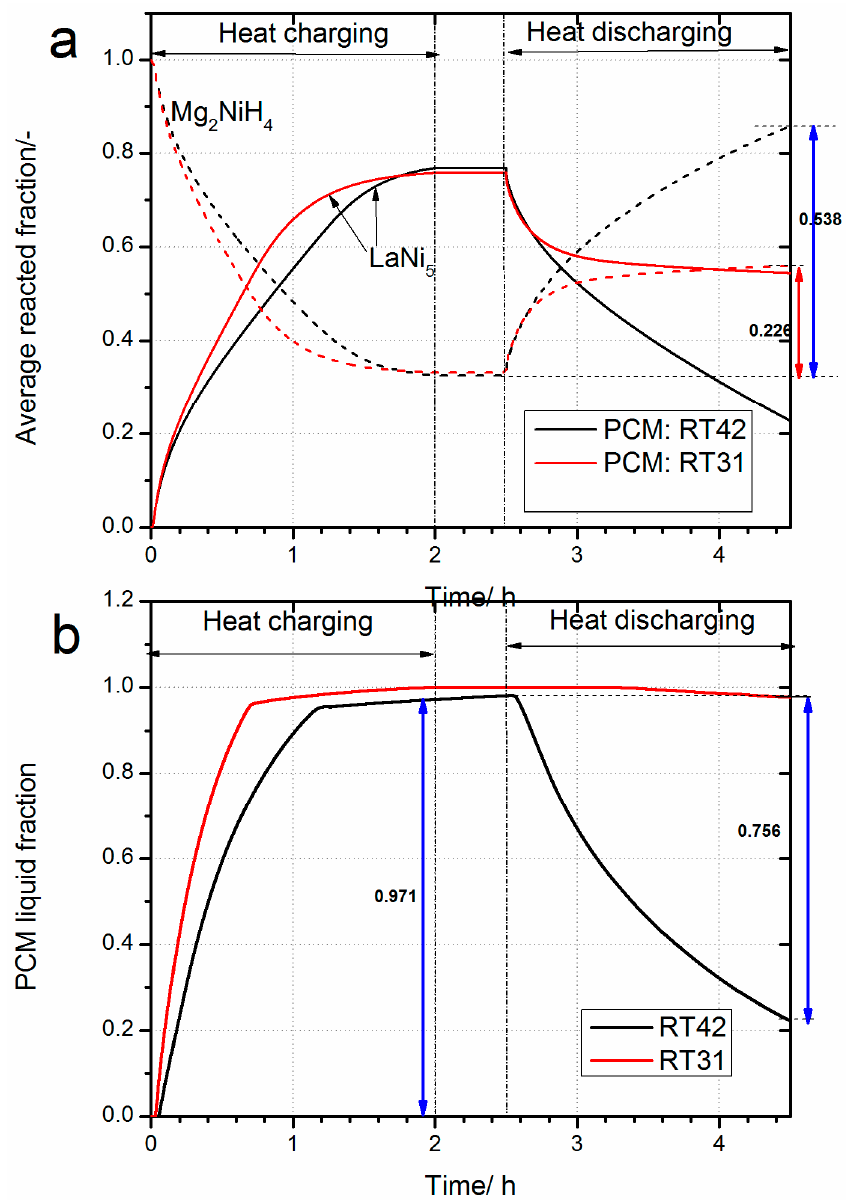
Figure 7. The influence of PCM melting point on the temporal profile of: ( a ) Average H 2 reacted fraction, ( b ) PCM melting fraction.